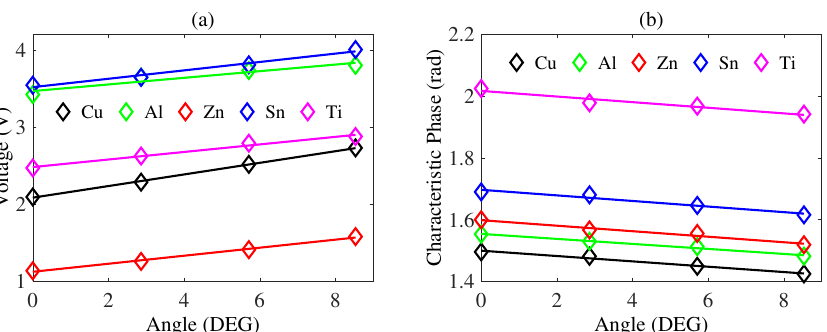
Figure 8. ( a ) Voltage versus angle where the black line denotes copper, the green line denotes aluminum, red line the denotes zinc, the blue line denotes tin and the magenta line denotes titanium. ( b ) Characteristic phase versus angles, where the black line denotes copper, the green line denotes aluminum, the red line denotes zinc, the blue line denotes tin and the magenta line denotes titanium.